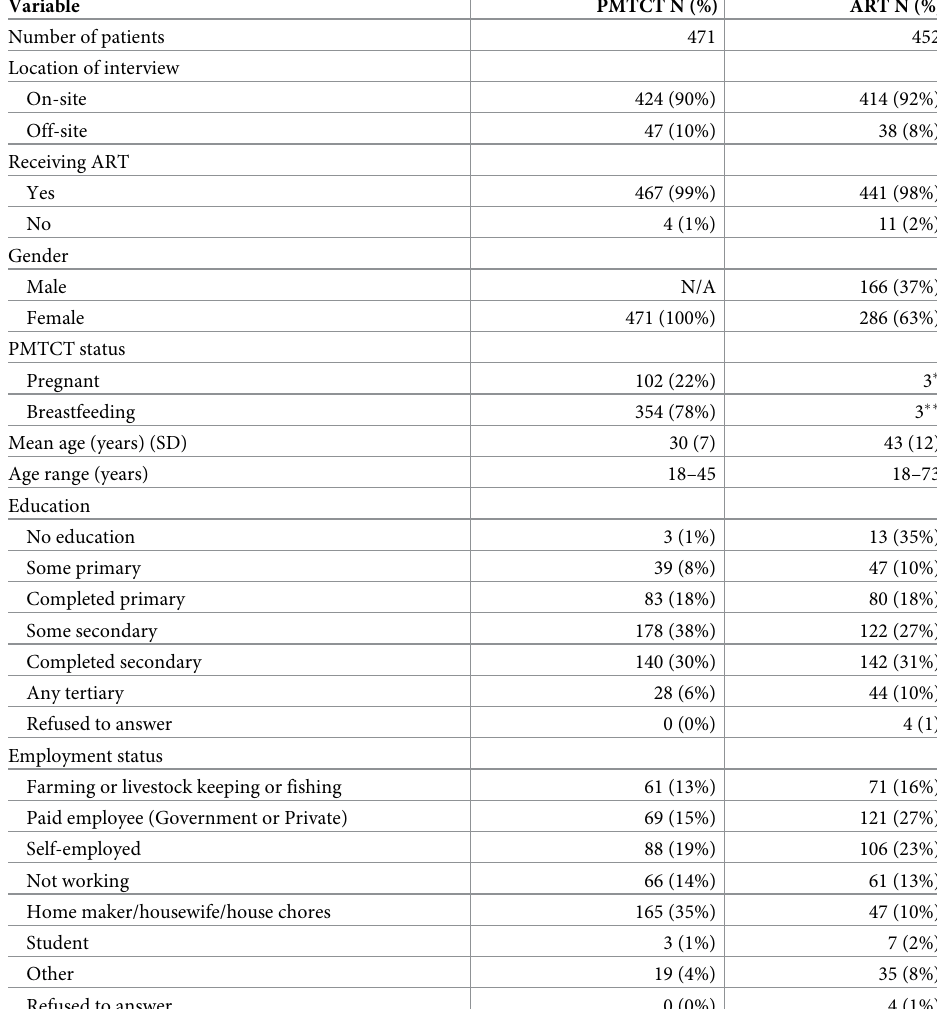
Table 2. Self-reported demographic characteristics for participants at the 20 participating facilities, Zimbabwe,